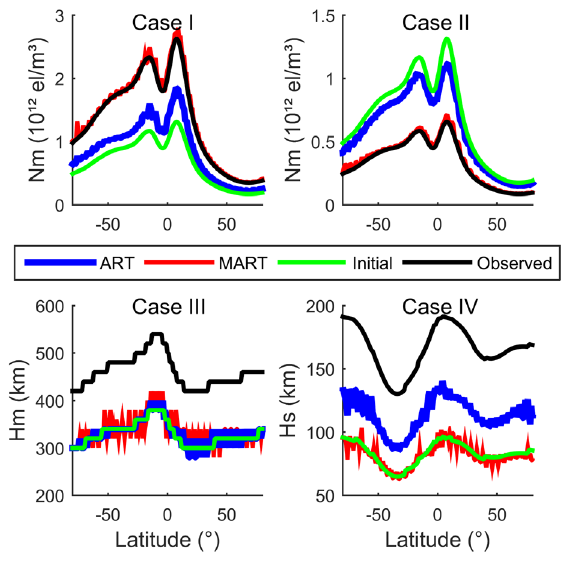
Figure 7 - Performance of ART and MART for estimating h and H in cases I, II, III, m s